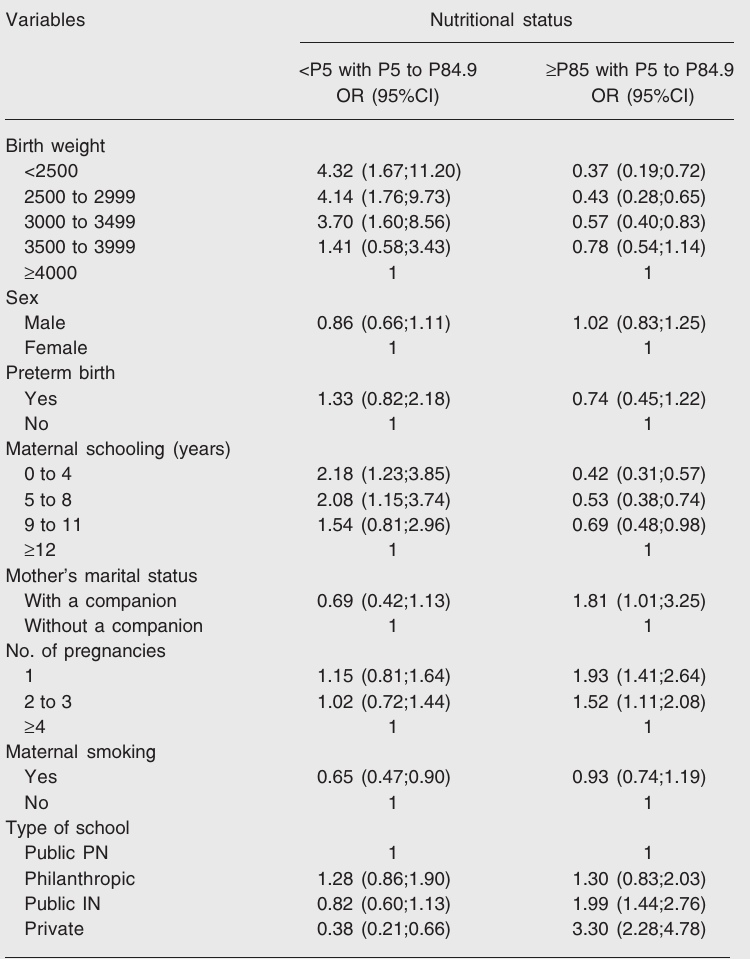
Table 3. Crude odds ratio for the comparison between the malnourished (<P5) and thin and normal (P5 to P84.9) classifications and between the excess weight ( ≥ P85) and thin and normal (P5 to P84.9)